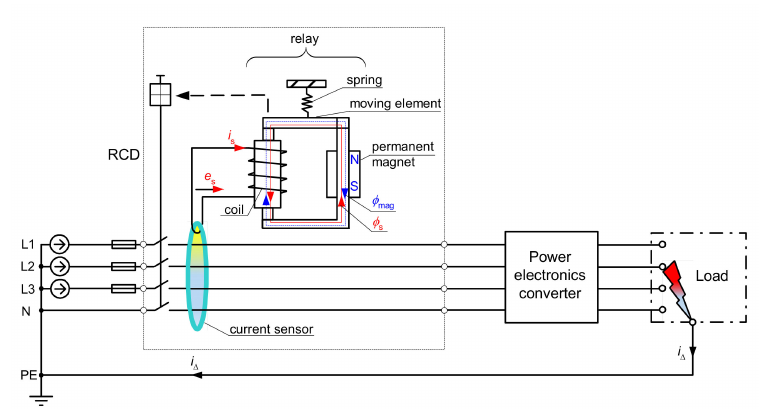
Figure 2. Residual current device (RCD) protecting a 3-phase circuit; e s —induced voltage